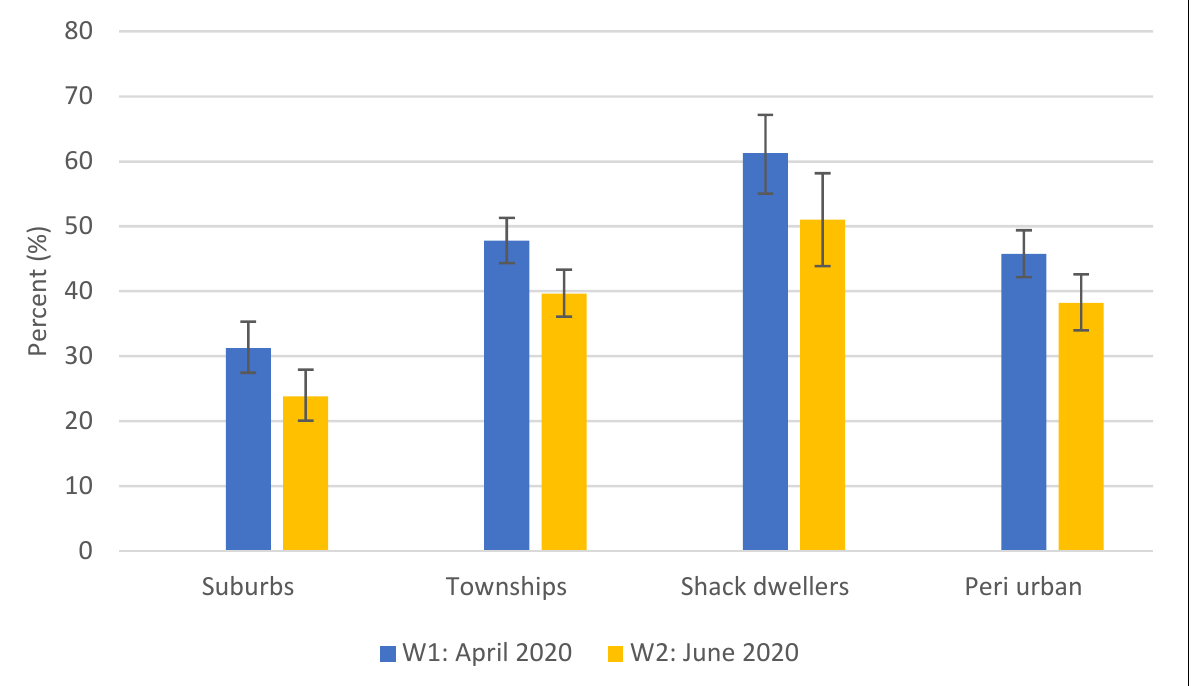
Figure 3: Percentage of adults who reported that their household ran out of money to buy